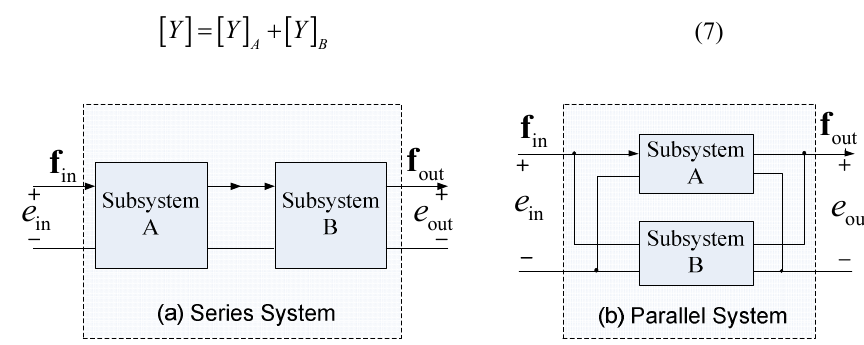
Fig. 3 Illustration of a system that consists of two subsystems connected (a) in series and (b) in